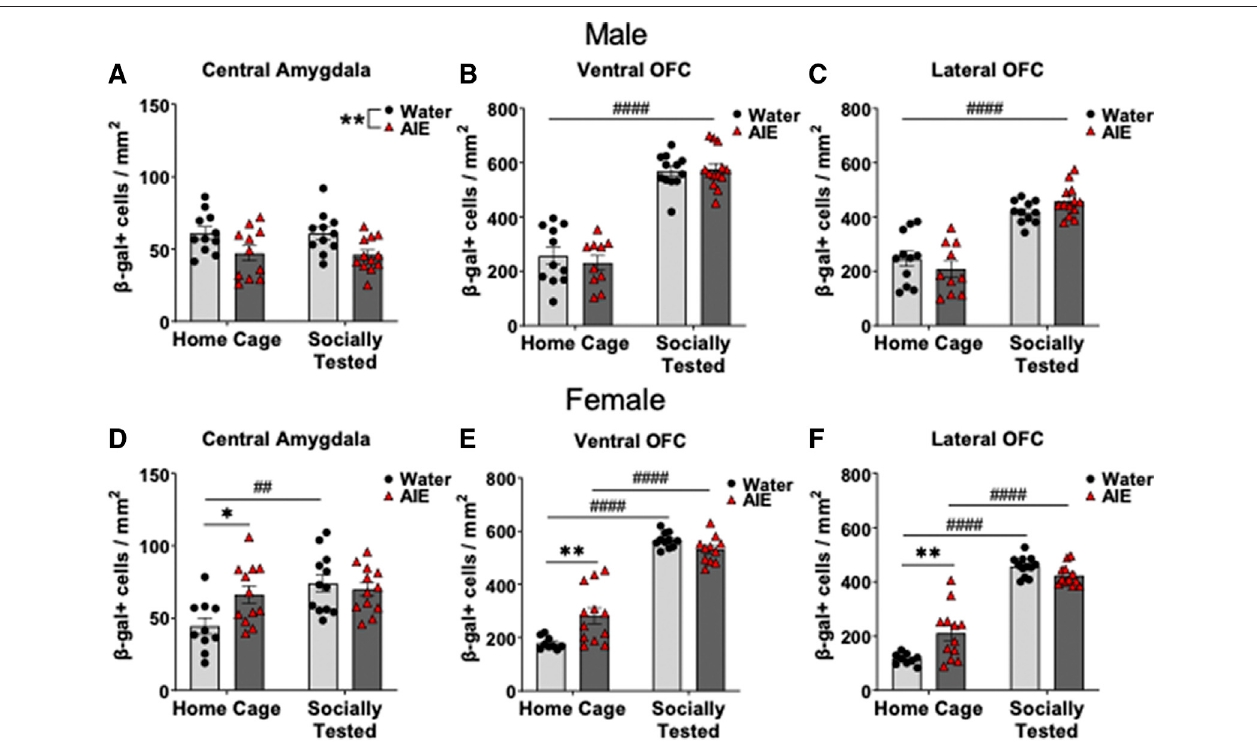
FIGURE 3 | Effects of adolescent intermittent ethanol (AIE) exposure on neuronal activation of (A,D) the central amygdala (CeA), (B,E) ventral orbitofrontal cortex (vOFC), and (C,F) lateral orbitofrontal cortex (lOFC) in home cage and socially tested adult males and females. Number of β -gal positive cells in the CeA was signi fi cantly lower in AIE-exposed males than in water-exposed controls, with no difference between social testing conditions. In females, CeA β -gal expression was greater for AIE- exposedhomecagesubjectscomparedwater-exposedcontrols.Sociallytested,water-exposedfemaleshadincreasedCeA β -galexpressioncomparedtohome cage water-exposed females. β -gal + cells were greater in both subregions of the OFC in socially tested males, regardless of adolescent exposure. In females, the number of β -gal + cells in the vOFC and lOFC was higher in home cage AIE-exposed females than in their water-exposed counterparts. Additionally, social testing in females led to increases β -gal expression in both OFC subregions, regardless of adolescent exposure. Asterisks denote signi fi cant differences between adolescent exposure conditions, * p ≤ 0.05, ** p = 0.01 whereas # denote signi fi cant differences between testing conditions, ## p < 0.01, #### p < 0.0001.